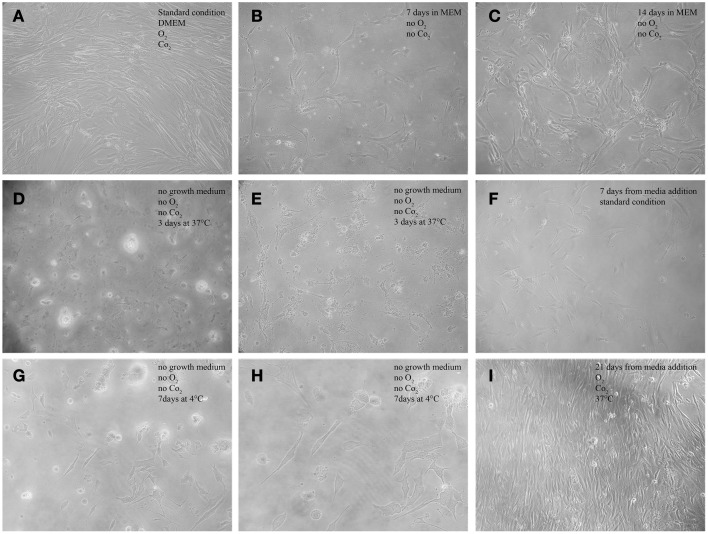
Morphological features of AAA-MSCs exposed to hypoxia, nutrient deprivation, dry culture, and/or cold temperature. (A) Typical spindle-shape morphology of confluent AAA-MSCs at passage 3, grown in standard culture conditions; (B) Clusters of AAA-MSCs cultured in no-vented closed flasks using MEM glucose-free at 7 days and (C) at 14 days from seeding, where a cell monolayer is visible; (D,E) AAA-MSCs subjected to media deprivation lost their typical structure, cytoplasmic prolongation and plasma membrane; (F) 7 days from media addition, an amount of survival cells was detected; (G,H) AAA-MSCs after media deprivation and 7 days at 4°C showed a volume contraction and the typical cell shape was lost; (I) after traditional media addition, AAA-MSCs restored their features and reached confluence; (A–G,I: 100x magnification; H: 200x magnification).